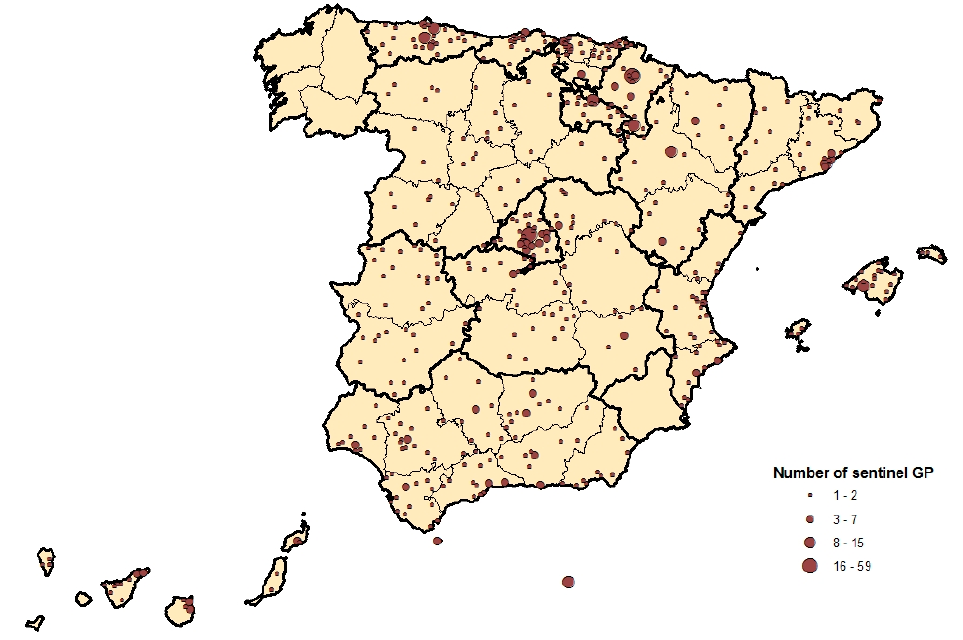
Figure 1. Distribution of sentinel physicians in the 2012/2013 influenza season.